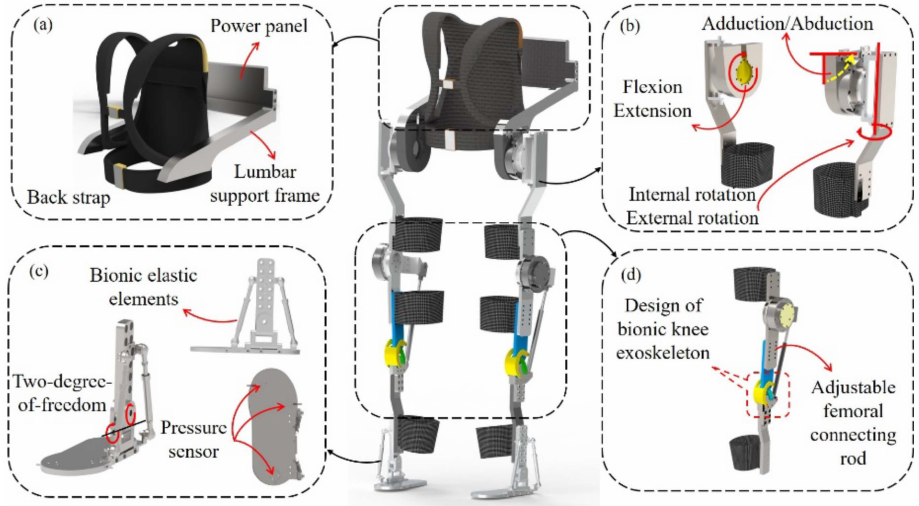
Figure 2. Structure diagram of lower-limb exoskeleton rehabilitation robot: ( a ) Waist exoskeleton structure diagram; ( b ) Hip joint exoskeleton structure diagram; ( c ) Ankle joint exoskeleton structure diagram; ( d ) Knee joint exoskeleton structure